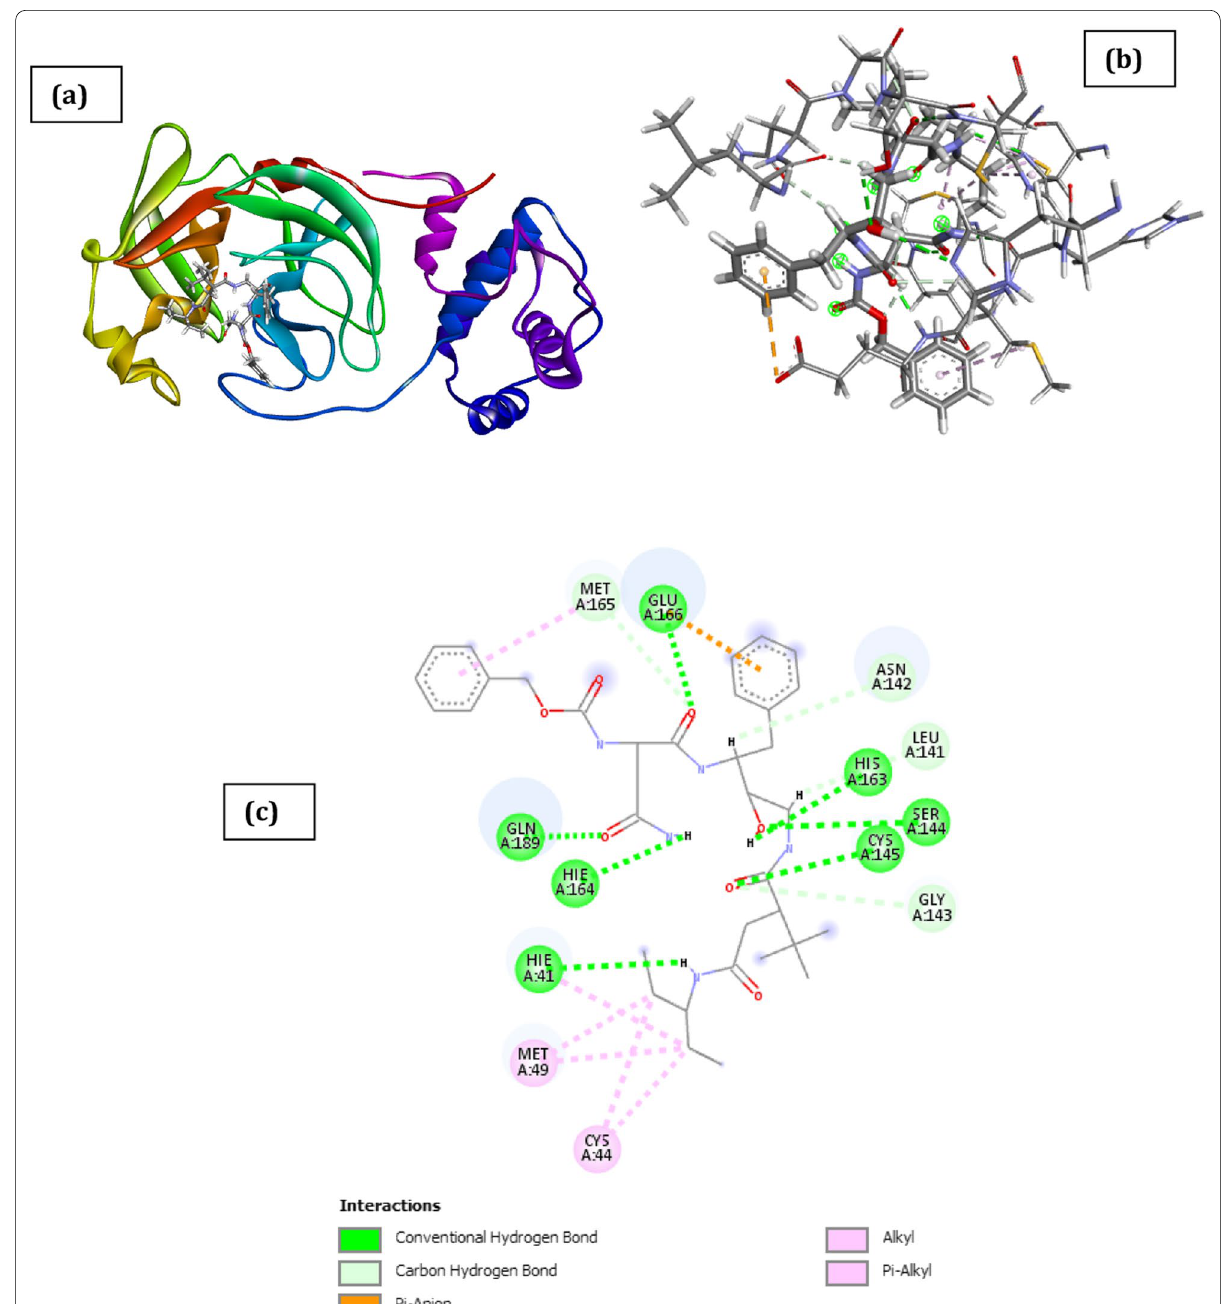
Fig. 7 Docked poses of SARS CoV 2 main protease (PDB ID: 6XBH) with inhibitor with Index number 847 (stick figure) a 3D view of docked pose of SARS CoV 2 Main Protease (PDB ID: 6XBH) with inhibitor with Index number 847; b 3D view of inhibitor with Index number 847 with surrounding amino acids of 6XBH; c 2D view of interaction type of inhibitor with Index number 847 with surrounding amino acids of